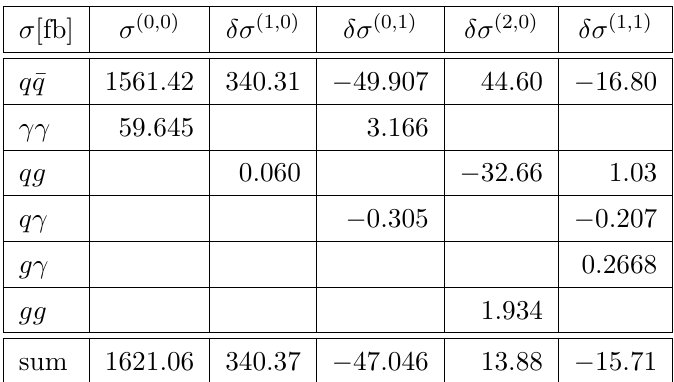
Table 1 . Results for fiducial cross sections for central value of the renormalization and factorization scales µ R = µ F = m ‘‘ / 2 . Contributions are separated by partonic channels. Selection cuts for final-state leptons and jets are given in eq. (4.1). Here, δσ ( i,j ) denotes the correction of relative order α i α j . We note that the numerical precision on the correction δσ (1 , 1) is about s